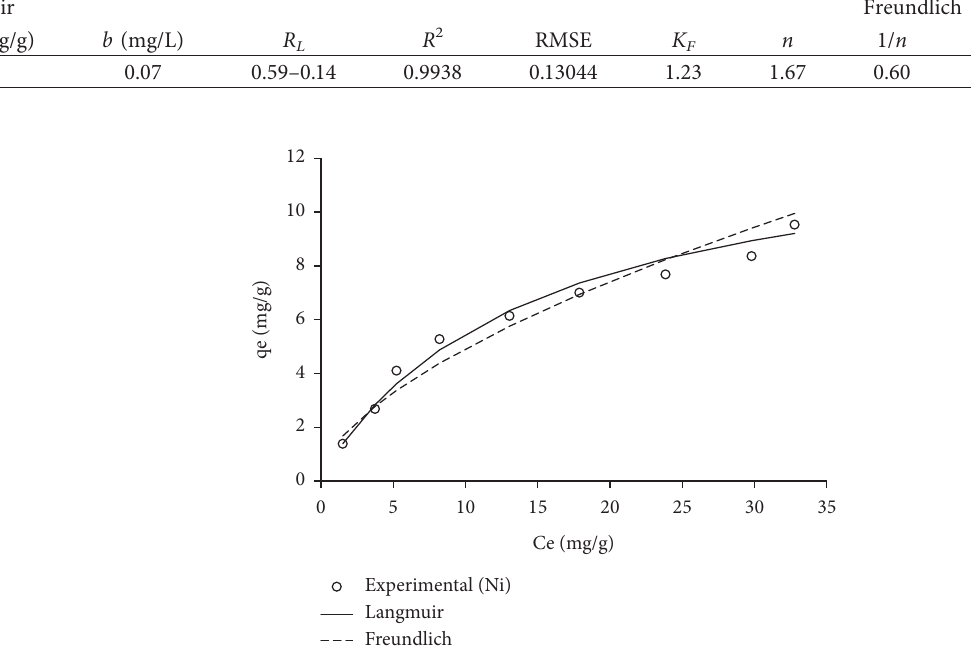
Figure 7: Nonlinear isotherm plots for Langmuir and Freundlich models.